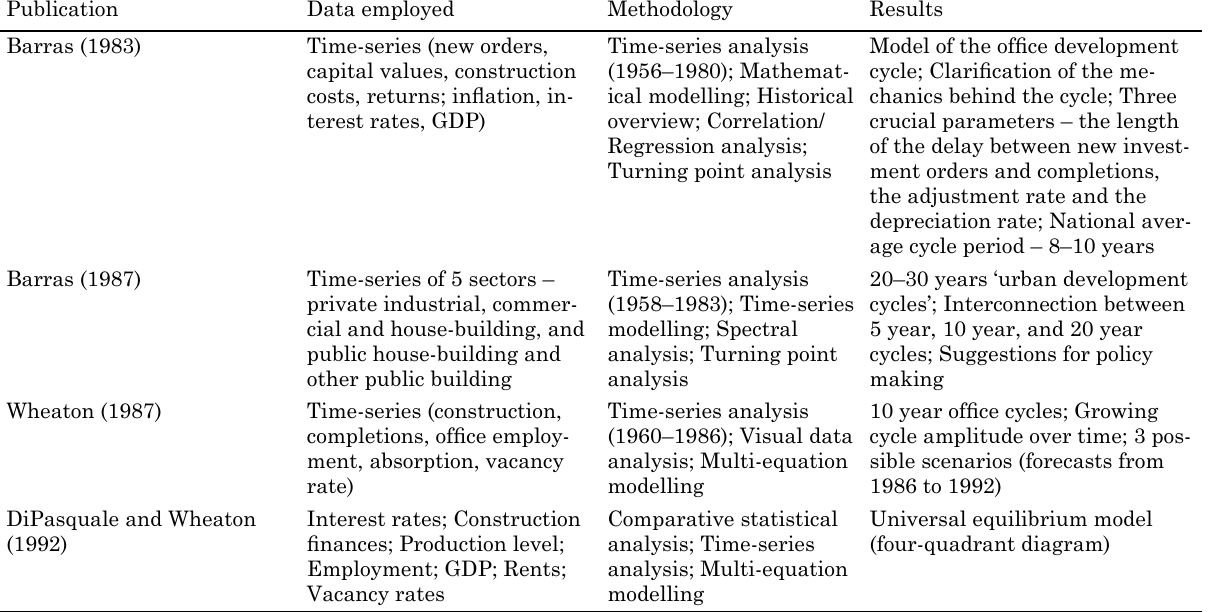
table 3. Key post-1970s crash publications on property